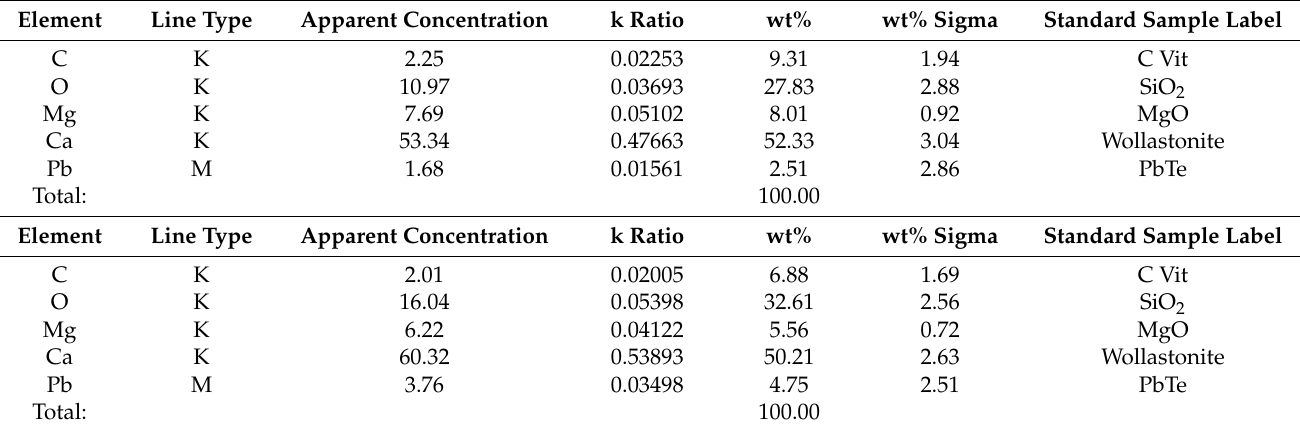
Table 3. EDS spectra of dolomite surface A and B areas after exposure to 50 mL of 50 mg/L PbCl 2 solutions for 15